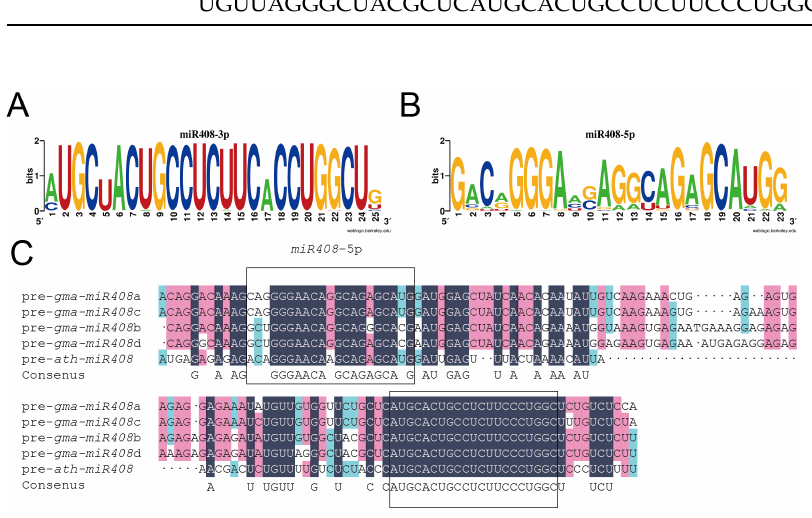
Figure 2. Multiple alignment of miR408 sequences. ( A ) Consensus sequences of mature miR408 -3p displayed by WebLogo. ( B ) Consensus sequences of mature miR408 -5p displayed by WebLogo. ( C ) Precursor sequence analysis of miR408 between Glycine max and Arabidopsis thaliana . Sequence alignment of pre- ath-miR408 and pre- gma-miR408 a/b/c/d. Boxes indicate the sequences of mature miR408 -3p and miR408